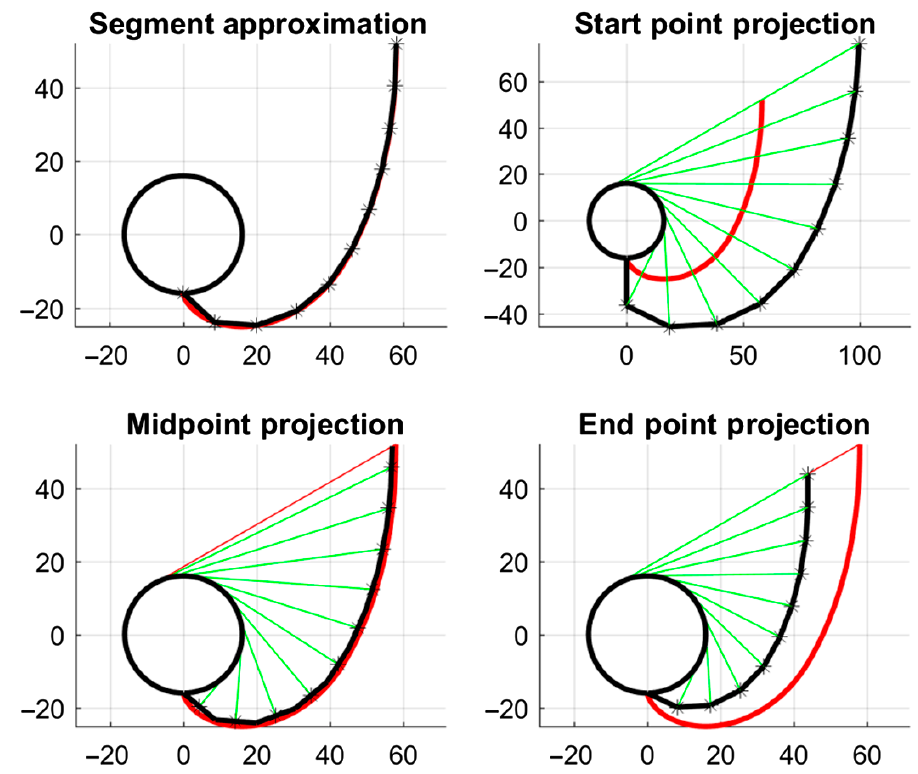
Figure 14. Methods to generate approximate profiles by using segment CPC [34].